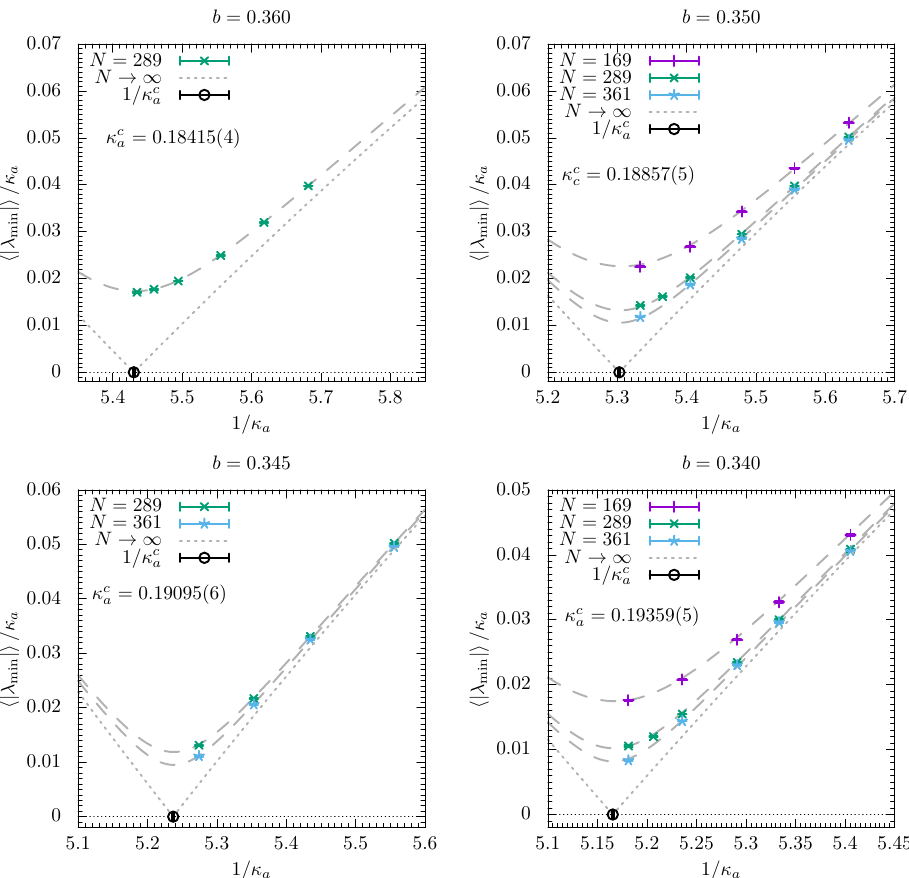
Figure 2. Dependence, for the 4 values of the bare coupling used in this work, of 1 / (2 κ a ) , where λ 2 stands for the minimum eigenvalue of Q 2 min plots correspond to fits to eq. (4.2), while the dotted lines represent the infinite N extrapolations, allowing to determine the value of the critical hopping parameter κ c